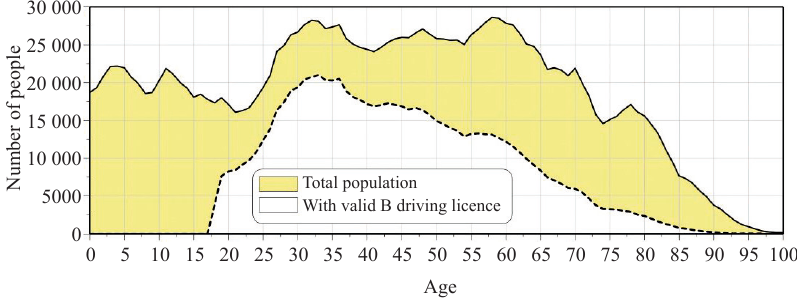
Figure 5. Population and category B drivers’ age distribution